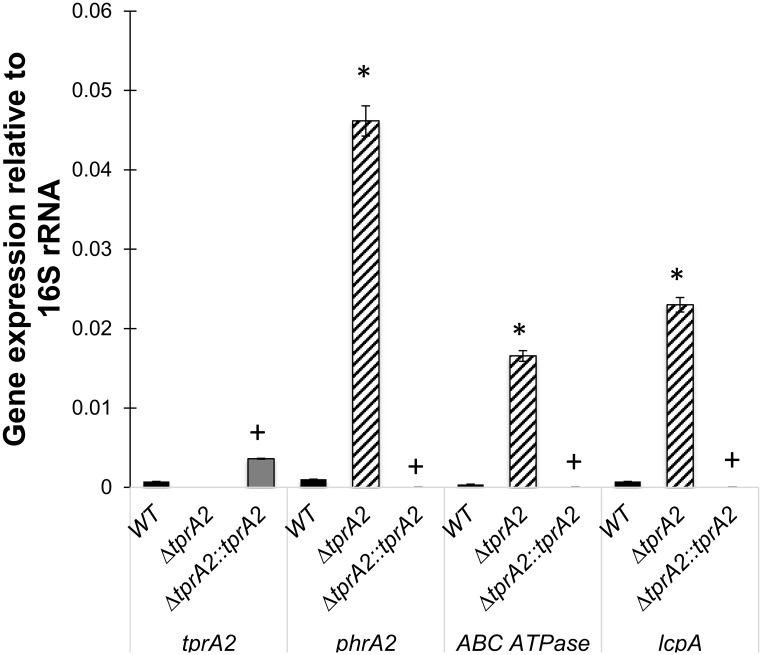
Analysis of the TprA2 regulon by comparison of gene expression levels among WT, ΔtprA2, and ΔtprA2::tprA2 strains.qRT-PCR measurements for genes tprA2, phrA2, ABCATPase and lcpA. X-axis represents genes that were tested for expression in strains WT, ΔtprA2 and ΔtprA2::tprA2. Y-axis denotes starting concentration of mRNA in arbitrary fluorescence units as calculated from LinRegPCR. Data was normalized to the expression of 16S rRNA. Error bars represent standard deviation for biological replicates (n = 3).‘*’ significantly different expression relative to WT (P-value < 0.005), ‘+’ significantly different expression relative to ΔtprA2 (P-value < 0.005).